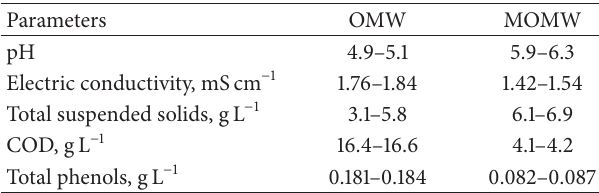
Table 1: Raw OMW and MOMW physicochemical